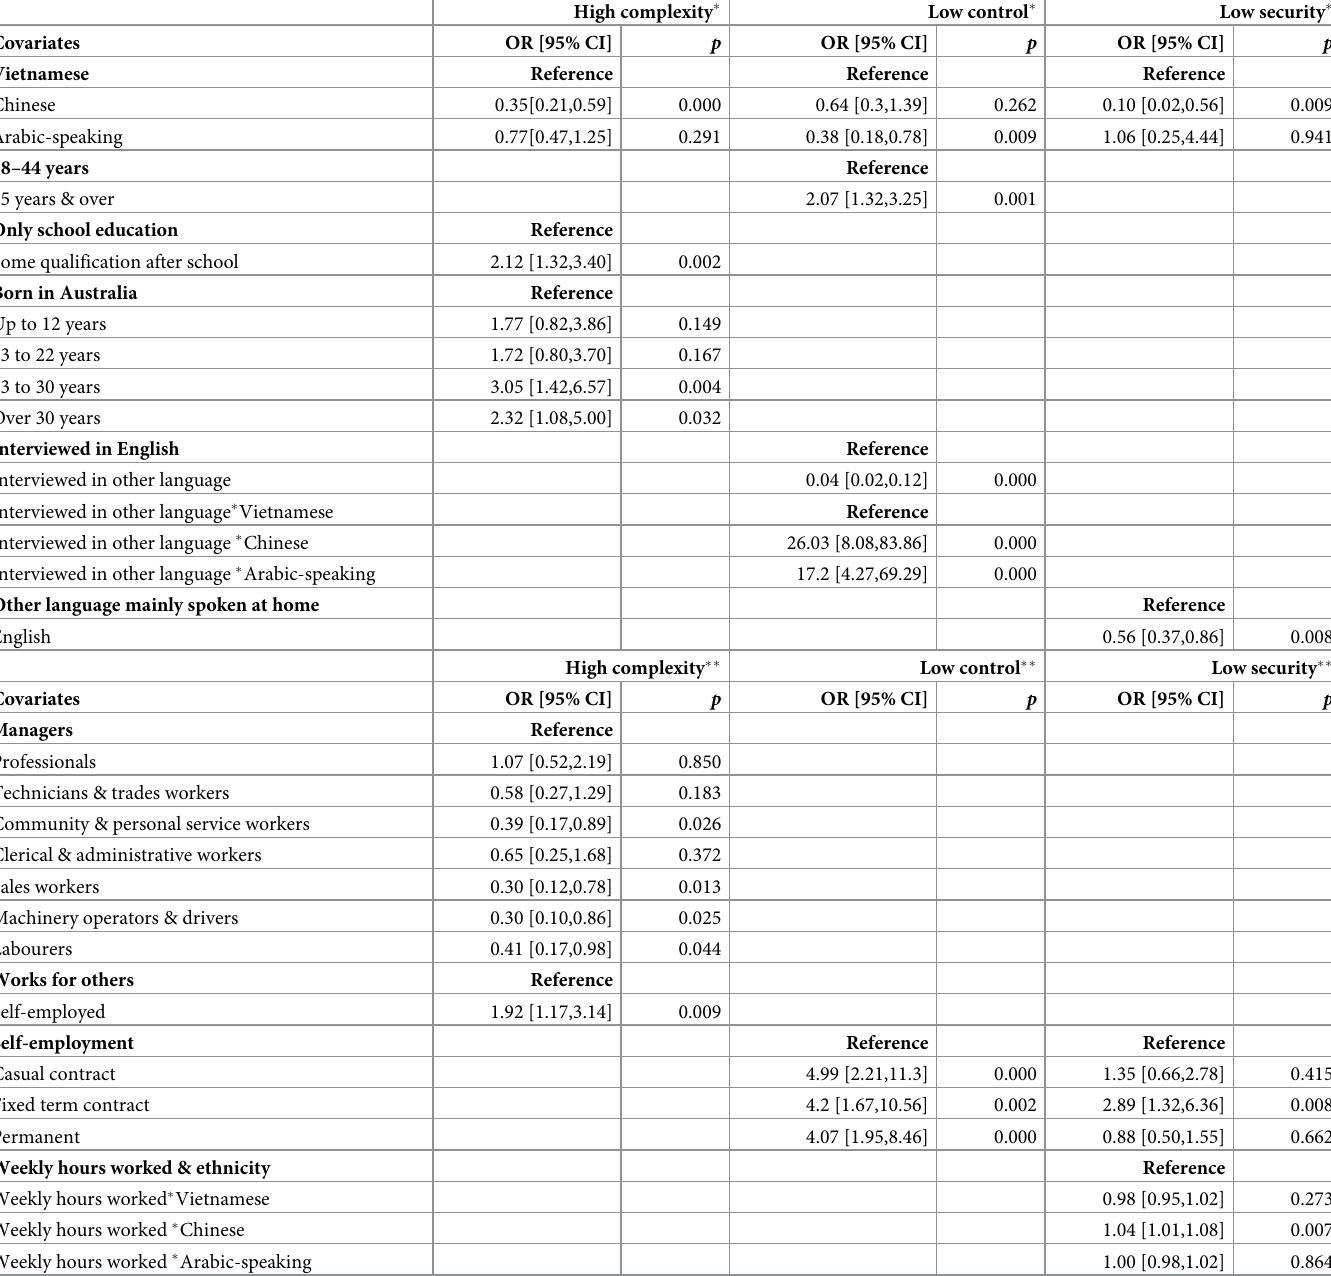
Table 2. Associations between socio demographics and employment and the three factors of psychosocial job quality among ethnic minority workers, with interac- tion